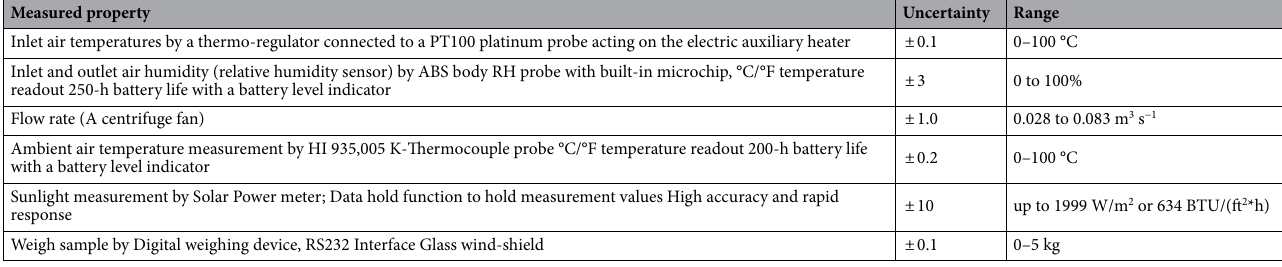
Table 1. Estimated uncertainties for different measurements. BTU British thermal unit; ft foot; W Watt; ABS absolute humidity; HR relative